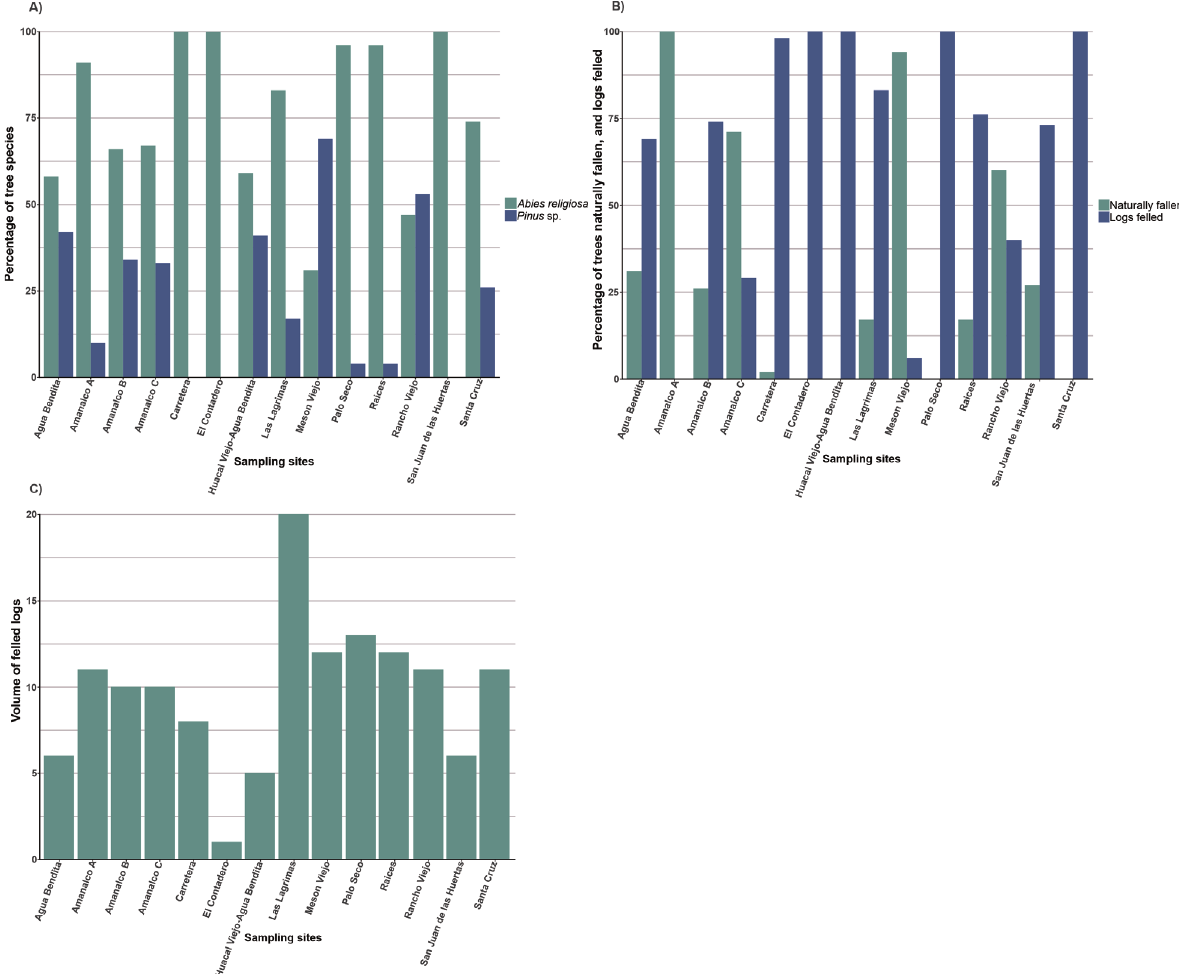
Figure 7. Characteristics of the logs per site: A) percentage of tree species; B) percentage of trees naturally fallen, and logs felled; C) volume of logs per